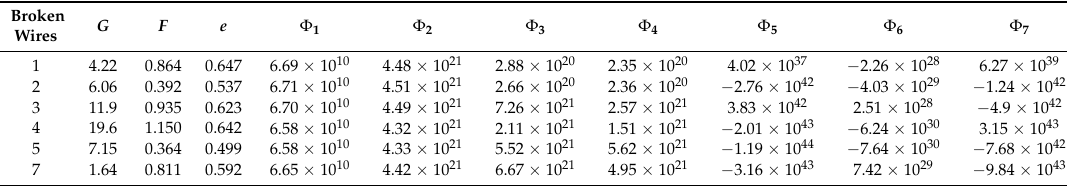
Table 1. Parts of the characteristic vectors of the